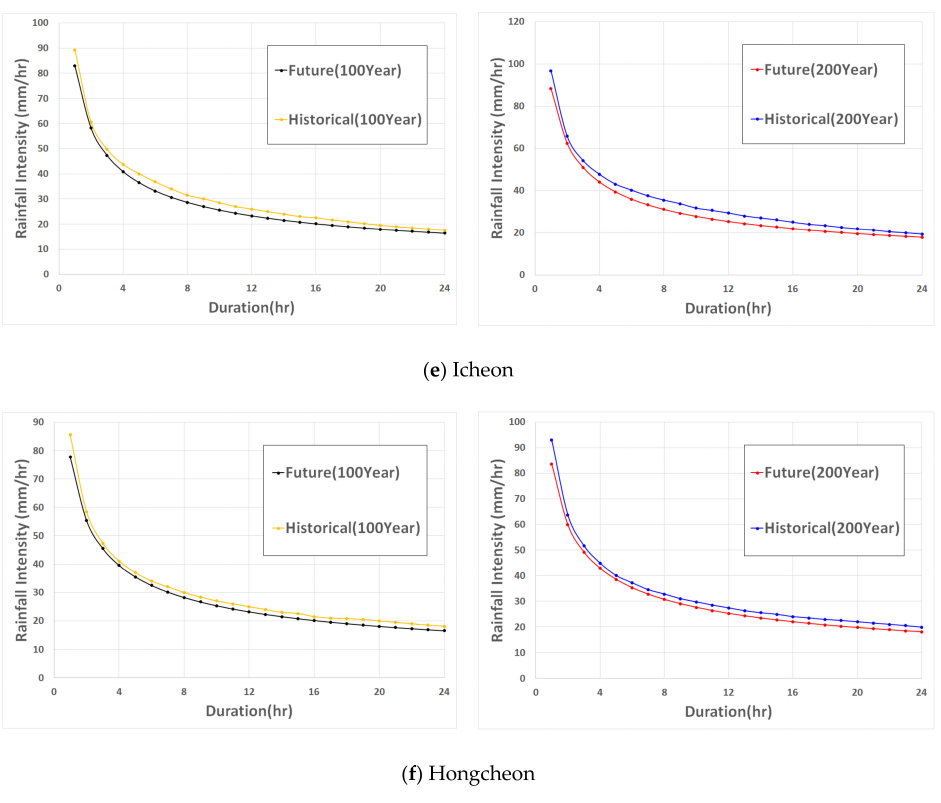
Figure 10. Result of I-D-F Curve by Return Period in Study